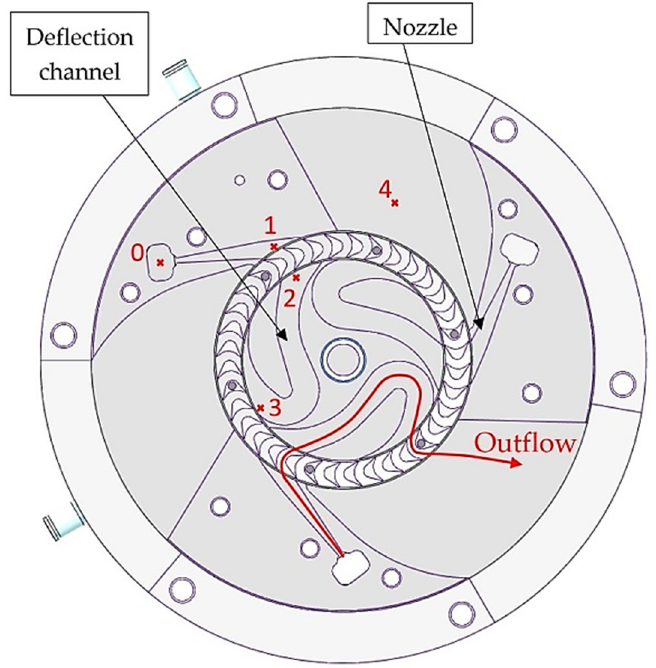
Figure 8. Sectional view of the examined Elektra turbine ( Version 1